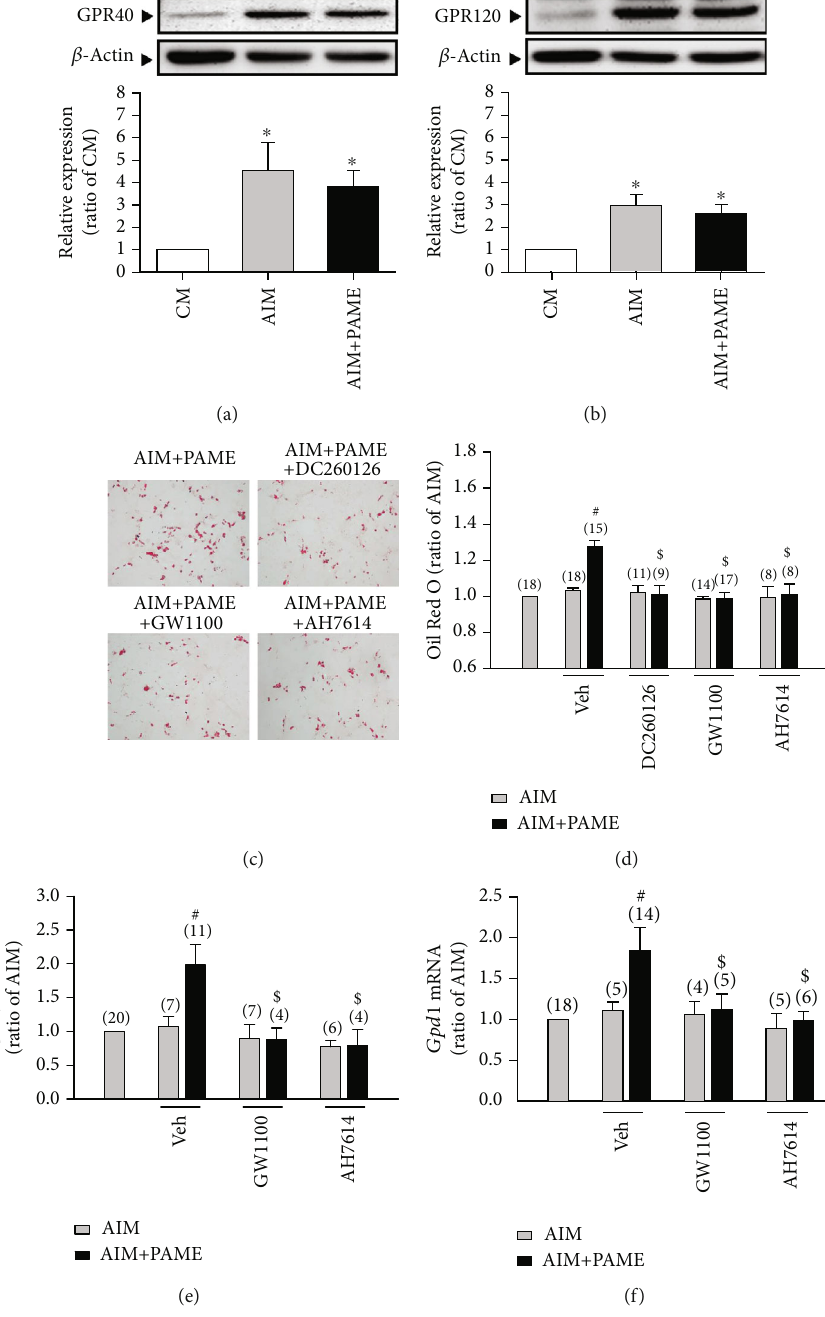
Figure 2: PAME activates the ERK1/2 pathway through stimulating the GPR40/120 in rAD-MSC adipogenic di ff erentiation. Treatment with or without PAME (50 μ M) in adipogenic induction medium for 12 days enhanced the protein levels of GPR40 (a) and GPR120 (b) ( n = 8 ). PAME (50 μ M) signi fi cantly enhanced the adipogenic di ff erentiation, and this e ff ect was inhibited by cotreatment with 5 μ M of GPR40 antagonist (DC260126 or GW1100) or 5 μ M of GPR120 antagonist (AH7614) (c, d). These antagonists were dissolved in 0.1% DMSO (vehicle). PAME signi fi cantly increased the mRNA levels of Ppar γ (e) and Gpd1 (f), and these e ff ects were abolished by cotreatment with GW1100 or AH7614. Values shown in parentheses represent the number in each group. All data represent mean ± SEM . ∗ p < 0 : 05 , versus the CM group; # p < 0 : 05 , versus the AIM group; $ p < 0 : 05 , versus the AIM+PAME group. CM: culture medium; AIM: adipogenic induction medium; Veh: